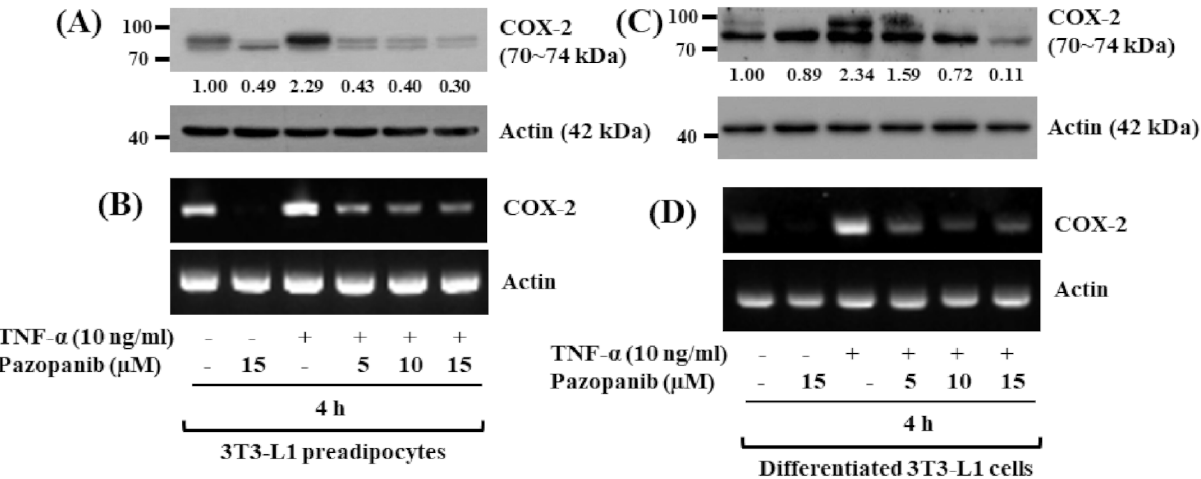
Figure 5. Effects of pazopanib on TNF- α -induced COX-2 expression in 3T3-L1 preadipocytes and differentiated cells. ( A , B ) 3T3-L1 preadipocytes were treated without or with TNF- α (10 ng/mL) in the presence or absence of pazopanib at the designated concentrations for 4 h. Whole-cell lysate and total RNA were prepared and analysed by Western blotting ( A ) and RT-PCR ( B ), respectively. ( C , D ) Differentiated 3T3-L1 cells on D8 were treated without or with TNF- α (10 ng/mL) in the presence or absence of pazopanib at the indicated doses for 4 h. Whole-cell lysate and total RNA were prepared and analysed by Western blotting ( C ) and RT-PCR ( D ),